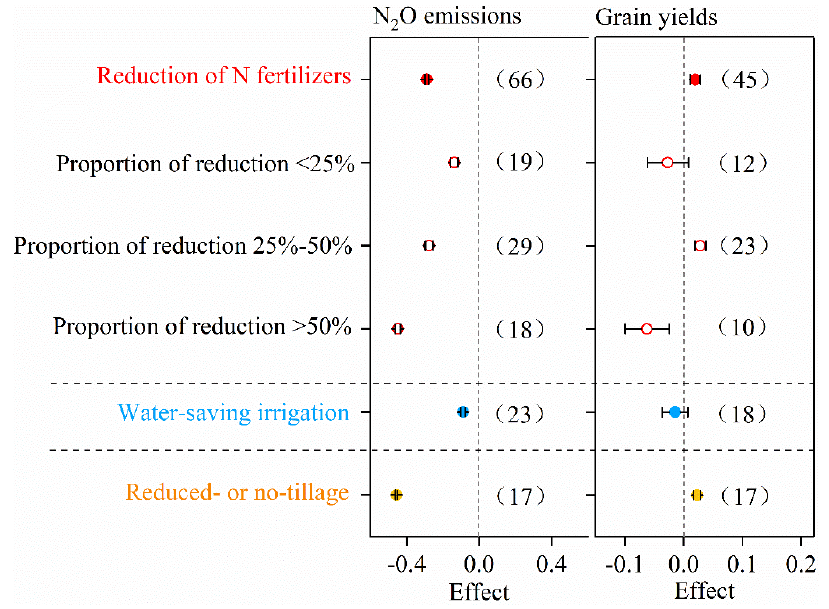
Figure 4. Impacts of various management practices on N 2 O emissions and grain yields. Data points are the weighted response ratio with 95% confidence intervals. Numerals indicate the sample size.